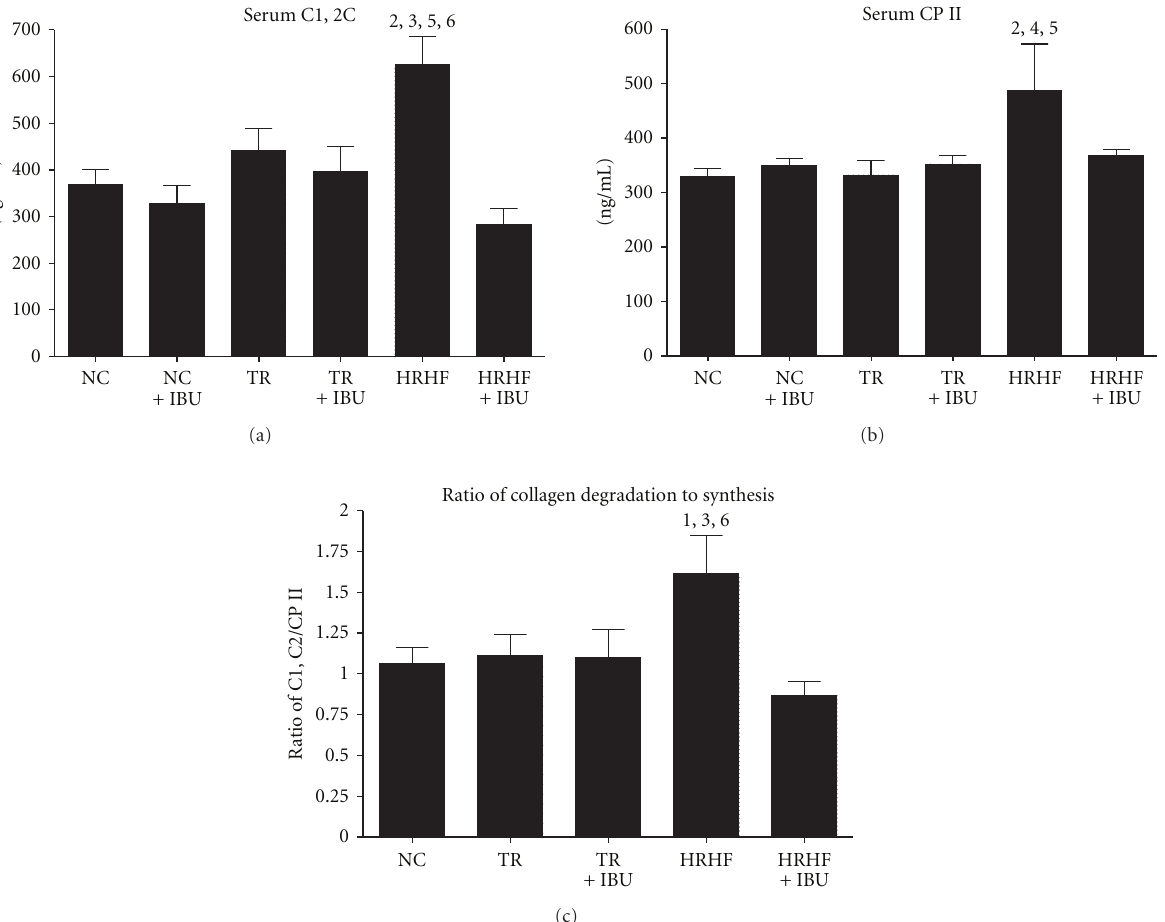
Figure 7: Serum concentrations of collagen degradation and synthesis markers, and the ratio of collagen degradation to synthesis in NC (normal control), NC + IBU (normal controls receiving ibuprofen for 8 weeks), TR (trained controls), TR + IBU (trained controls receiving ibuprofen treatment in final 8 weeks), HRHF (rats performing high-repetition high-force task for 12 weeks), and HRHF + IBU (HRHF rats receiving ibuprofen treatment in final 8 weeks). (a) C1, 2C, a marker of collagen Type I and II cleavage (degradation). (b) CPII, a marker of procollagen II C-propeptide synthesis. (c) Ratio of C1, C2 (degradation) to CPII (synthesis). 1 = P < . 05 and 2 = P < . 01 compared to NC; 3 = P < . 01 compared to NC + IBU; 4 = P < . 05 compared to TR; 5 = P < . 05 compared to TR + IBU; 6 = P < . 01 compared to HRHF +